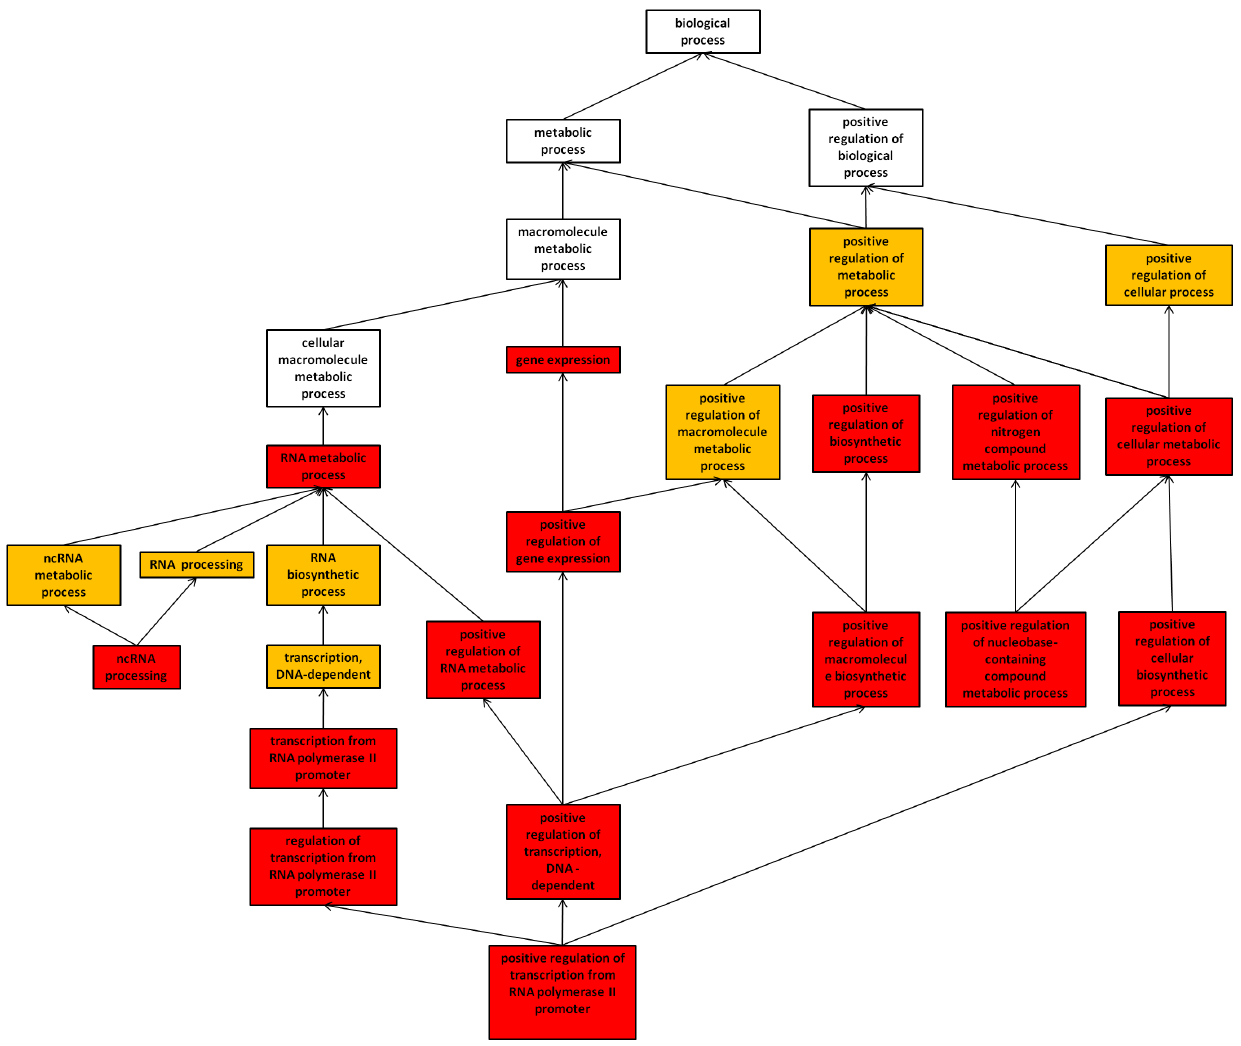
Figure 2. Tree of the biological processes up-regulated in differentiated Caco-2 cells after CYN exposure. The 522 genes showing up- regulation after 24 hrs exposure to 1.6 m M CYN were annotated within 22 biological processes (GO terms) with an enrichment score greater than 1.5. GO terms had a false discovery rate score of between 0.05 and 0.01 (in orange) or less than 0.01 (in red); white GO terms were ancestors.